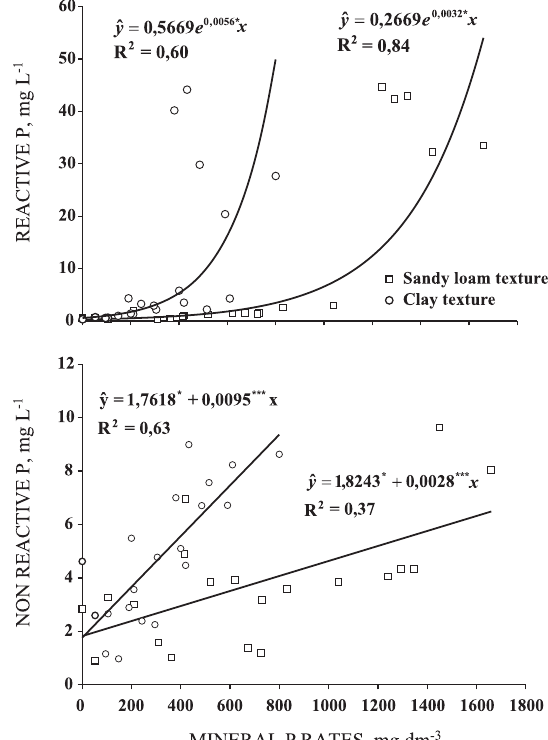
Figure 8. Concentration of reactive P (Pi) and non- reactive P (Po) in the leachates according to the rate of total mineral P applied in the first ring (0–10 cm), calculated by the sum of mineral prefertilization and poultry litter application, presuming that 61 % of the total of this material is in the inorganic form, in samples of two Latosols with sandy loam and clay texture. *, ***: significant at 5 and 0.1 %,